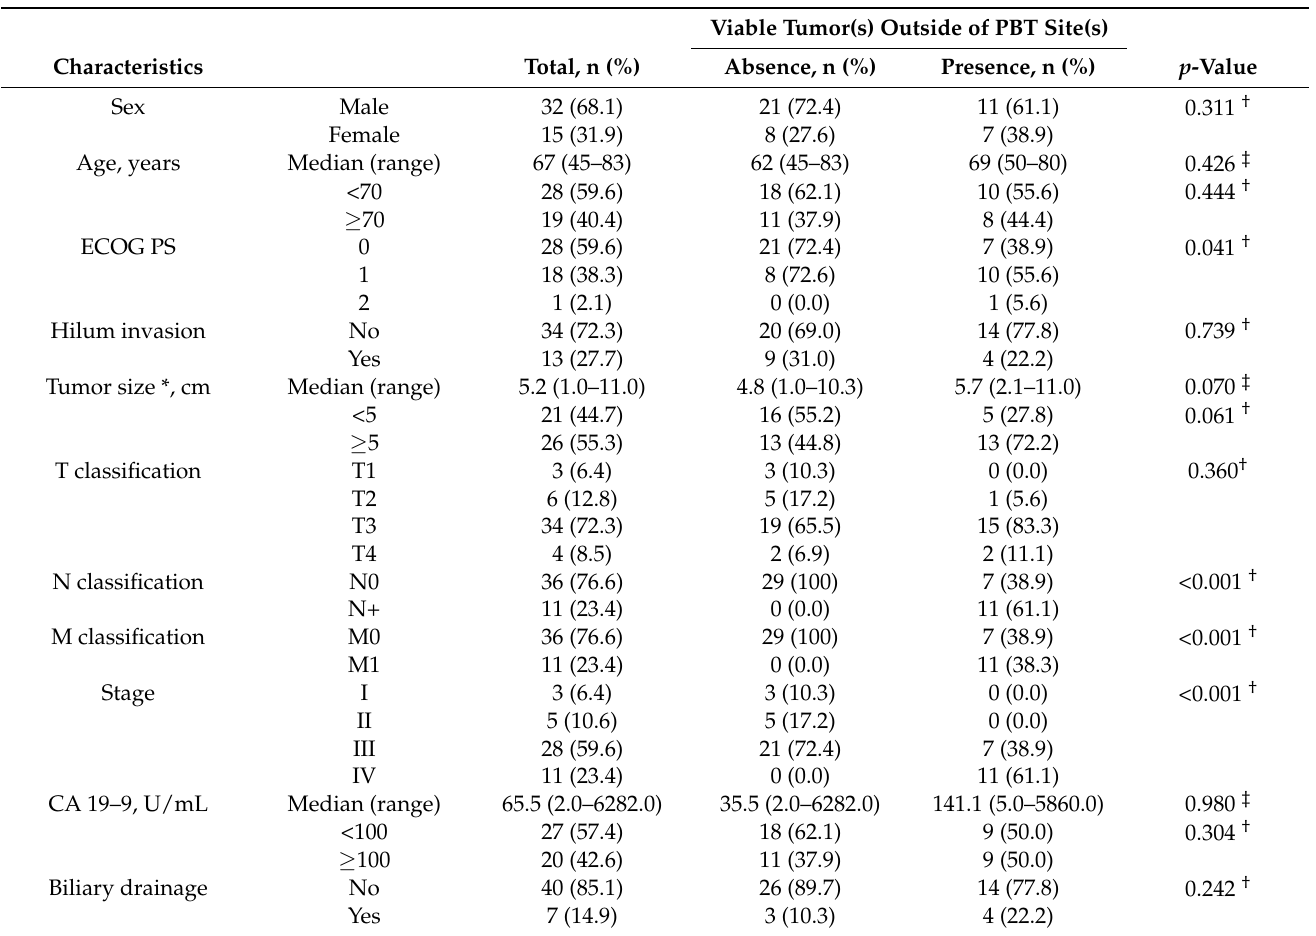
Table 1. Patient and treatment